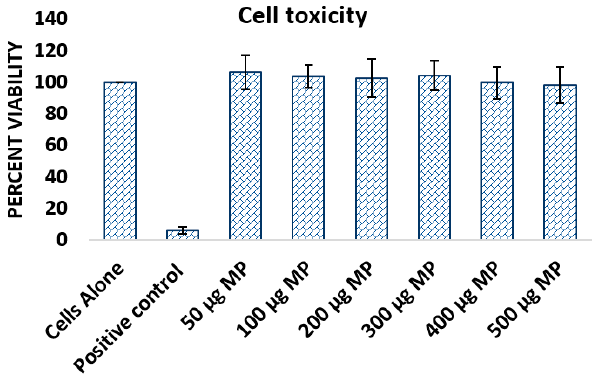
Figure 3. Dosage dependent toxicity test of microparticles on RAW264 murine macrophages cell line. Albumin based microparticles are not toxic to macrophages. RAW264 murine macrophages treated with increasing doses of microparticles and incubated overnight. The cytotoxicity was analyzed by the Alamar Blue assay that uses the reducing power of living cells to quantitatively measure cell viability. Atropine sulphate is the positive control and cell only serves as the negative control. Vaccine-loaded microparticles were not cytotoxic for the studied concentrations ranging between 50 to 500 µg. Results are expressed as mean ± standard error ( n = 3).